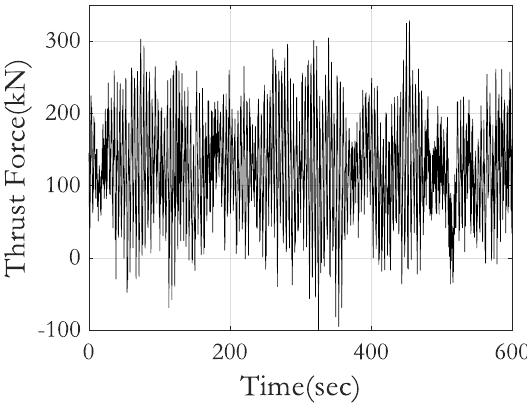
Figure 8. Time history of thrust force